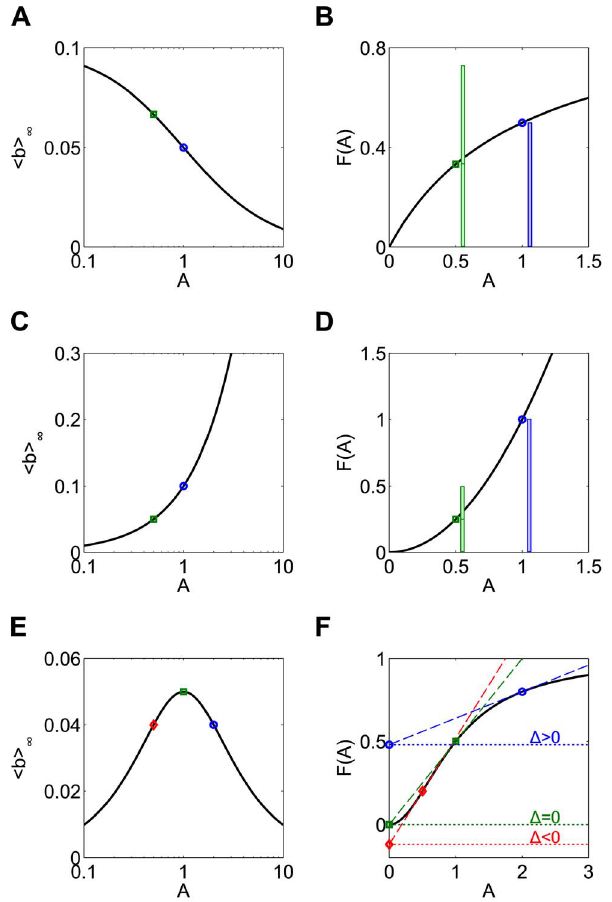
Figure 4. The optimal pulse shape depends on the shape of the nonlinearity. ( A ) The response is maximized for a sublinear production rate function when the pulse amplitude is minimized. A 0 =1 and d 0 =10 at frequency T 0 =100 so the minimum amplitude possible is A=A 0 d 0 /T 0 =0.1. ( B ) When the duration of the initial signal (blue circle) is doubled (green square), the amplitude of input is halved. Because of the saturating shape of the production rate function (here F(A)=A/(A + 1) is shown), the production of b caused by two small pulses (green bars) is more than the production caused by one large pulse (blue bar), despite the input having the same total dose. ( C ) Superlinear production rate functions lead to large responses for large pulse amplitudes. ( D ) The production of b caused by two small pulses (green bars) is less than the production caused by one large pulse (blue bar). The production rate function is F(A)=A 2 . ( E ) Sigmoidal production rate functions give rise to bell-shaped response. ( F ) For low amplitude input (red diamond), F(A) is superlinear, so the response is increasing. For high amplitude input (blue circle), the production rate function is saturating, so a decreasing response is expected. A maximal response therefore occurs at an intermediate frequency (green square). The slope of the response curve ( , b . ‘ ) is proportional to D , the difference between F(0) and the y-intercept of the line tangent to F(A). The peak frequency occurs when D =0. The production rate function is F(A)=A 2 / (A 2 + 1).